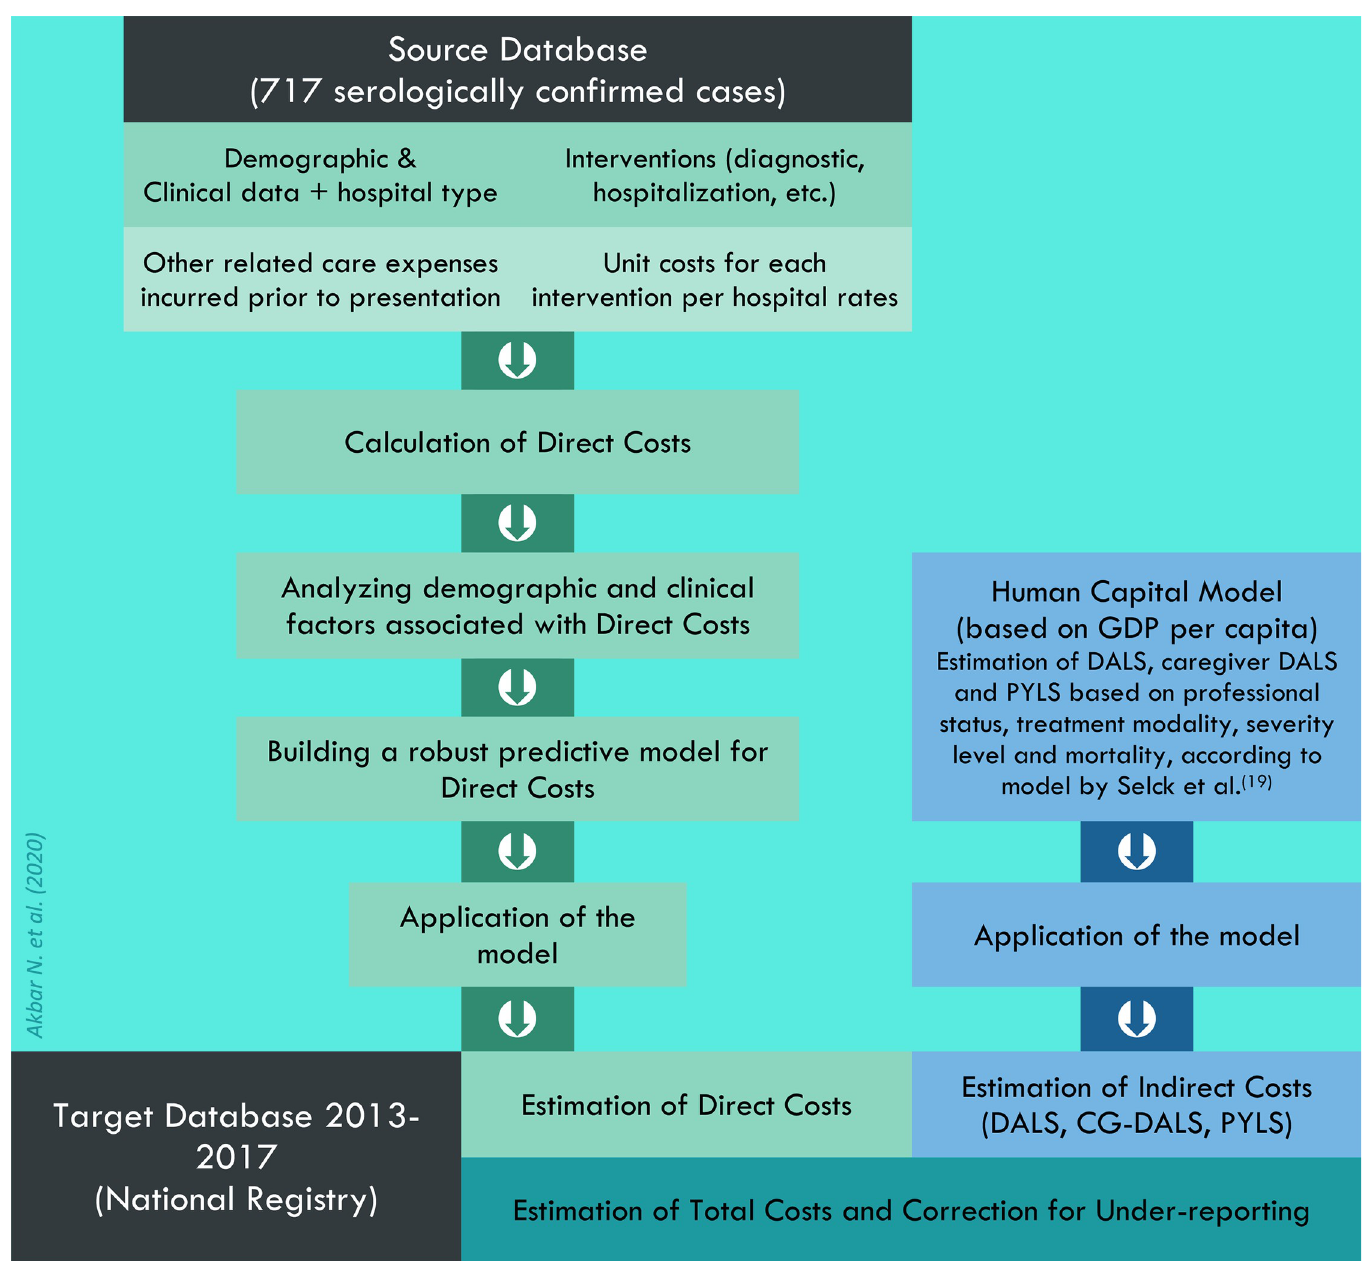
Fig 1. Estimation of dengue hemorrhagic fever cost of illness by estimating Direct Costs using Bottom-Up approach and Indirect Costs using Human Capital Model (Akbar et al, 2020).